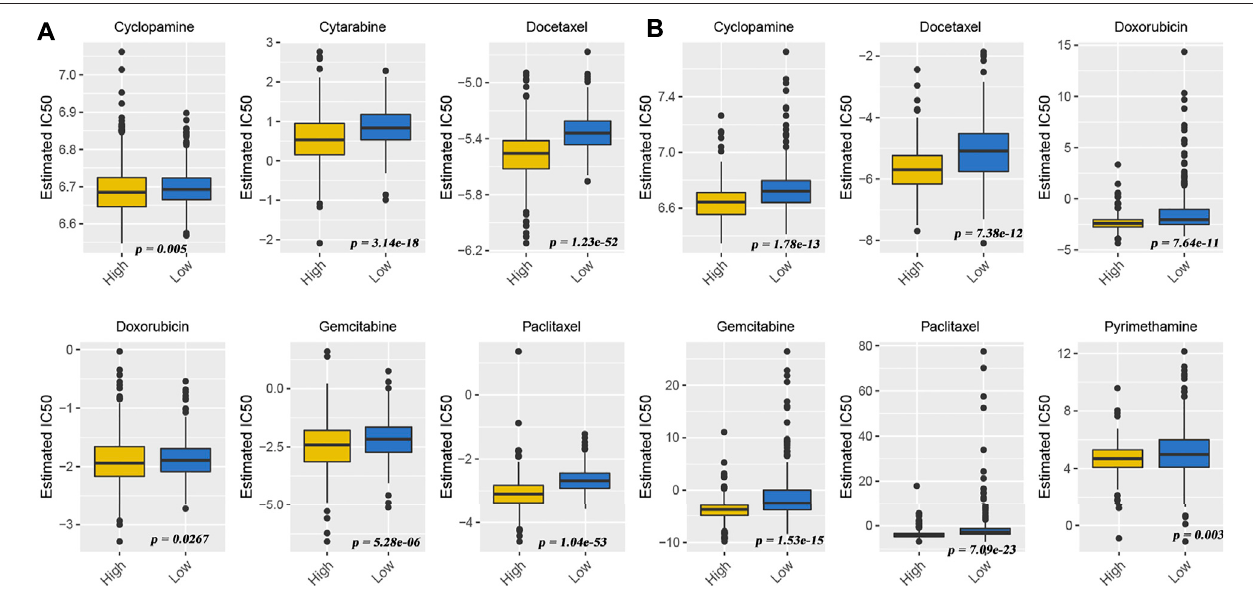
FIGURE 6 | Drug sensitivity comparison between high- and low-HDACsScore groups. Distribution of the estimated IC 50 of cyclopamine, docetaxel, doxorubicin, gemcitabine, paclitaxel, and pyrimethamine between high- and low-HDACsScore groups in the meta-GEO cohort (A) and TCGA cohort (B) .